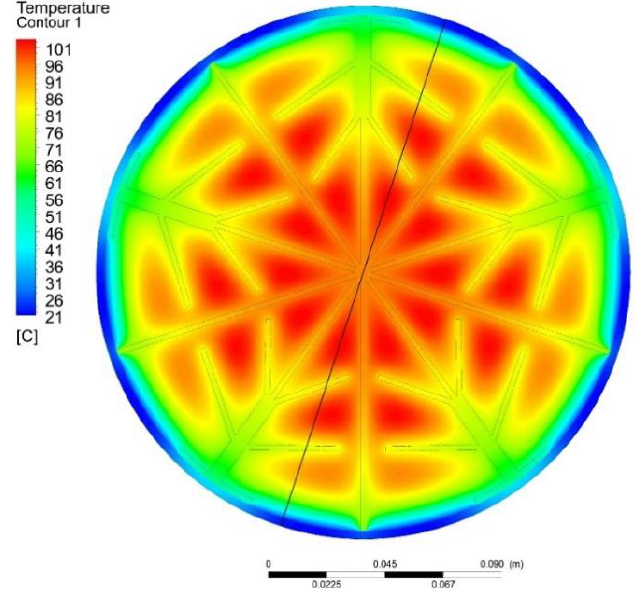
Figure 11. Temperature changes over time in the radial direction in Geometry 4.